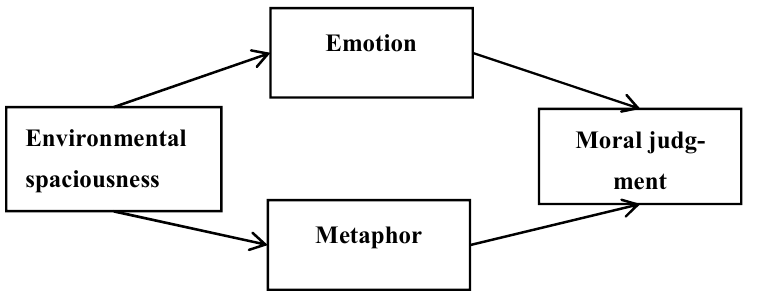
Figure 1. Hypothesized model depicting the relation between environmental spaciousness and moral judgment.